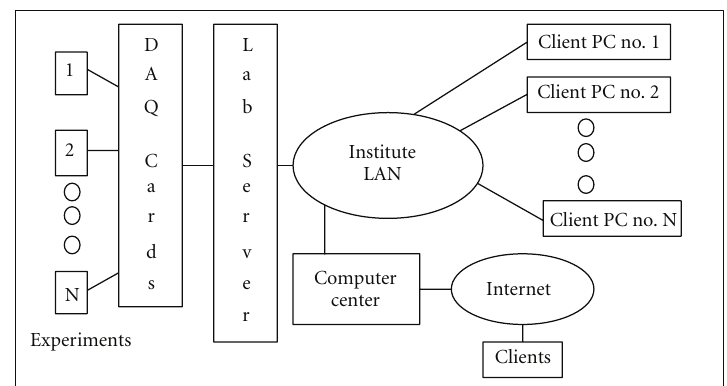
Figure 1: System architecture of remote lab.